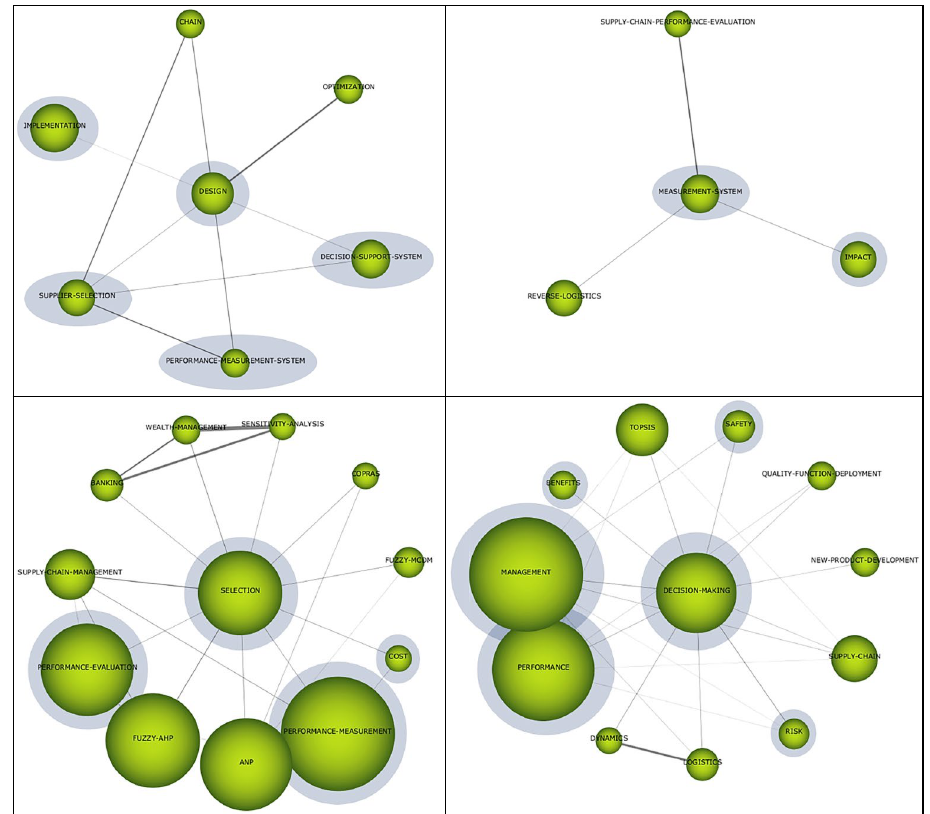
Figure 2. Thematic network of transversal themes, with highlighted related